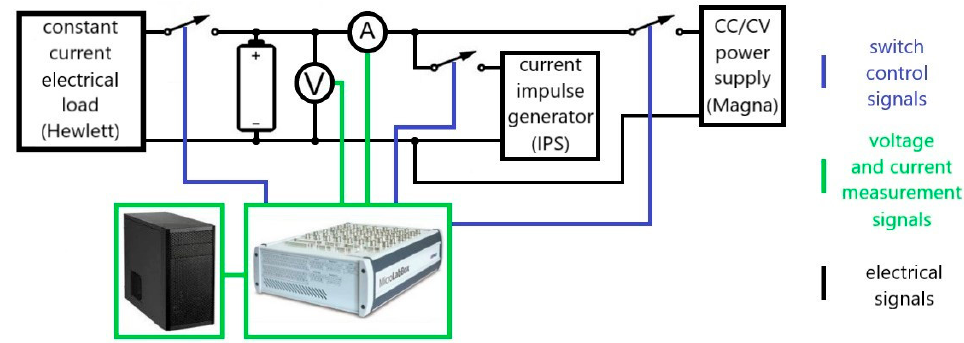
Figure 4. Electrical scheme of the experimental setup.